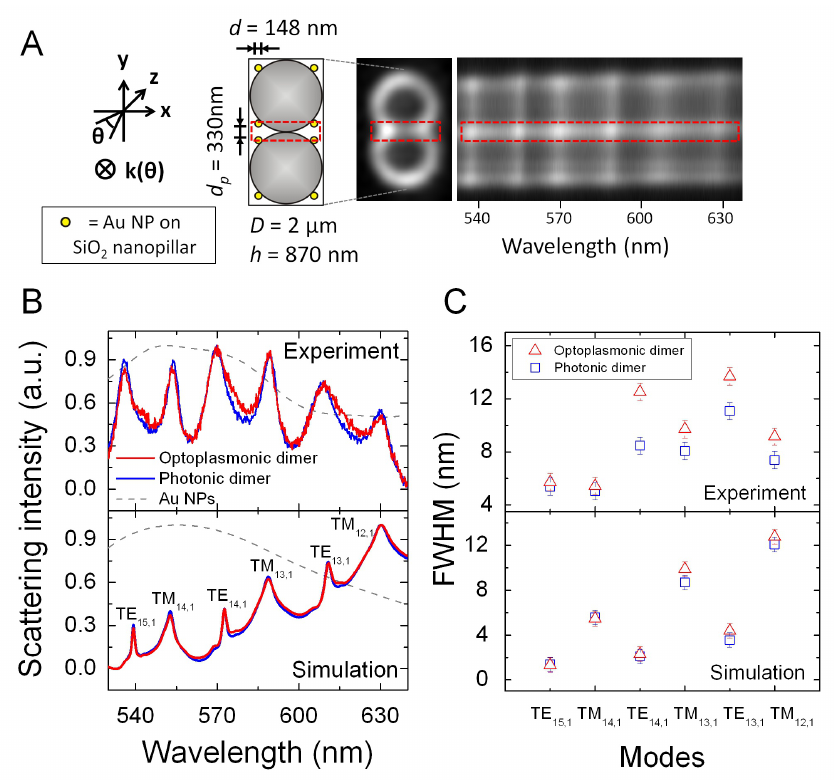
Figure 4: Characterization of the optoplasmonic dimer through scattering darkfield microscopy/spectroscopy. (A) Geometry of the optoplas- monic dimer, scattering image and spectrally resolved scattering image. (B) Experimental (top) and simulated (bottom) scattering spectra of the optoplasmonic dimer (red) and photonic control (blue) without Au nanoparticle tips. (C) Full width at half maximum (fwhm) of the indi- vidual modes shown in (B). Reprinted with permission from Ahn et al. ACS Nano 6, 951 (2012). Copyright 2012 American Chemical